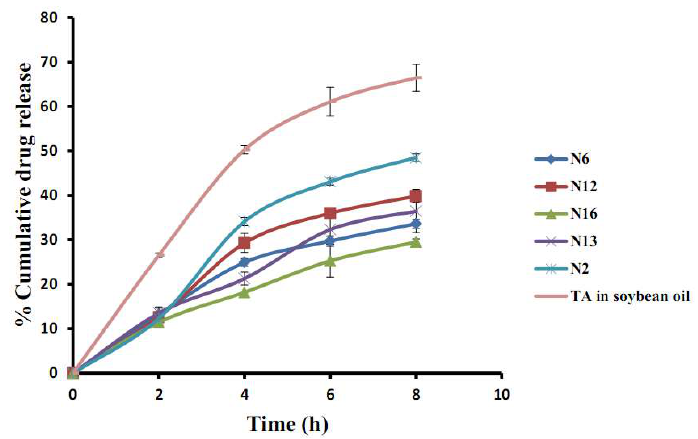
Figure 5. The in vitro release of TA from the TA-loaded NLCs and TA in soybean oil in simulated saliva fluid pH 6.8. Table 2. The in vitro release kinetics of triamcinolone acetonide-loaded nanostructured lipid carriers.